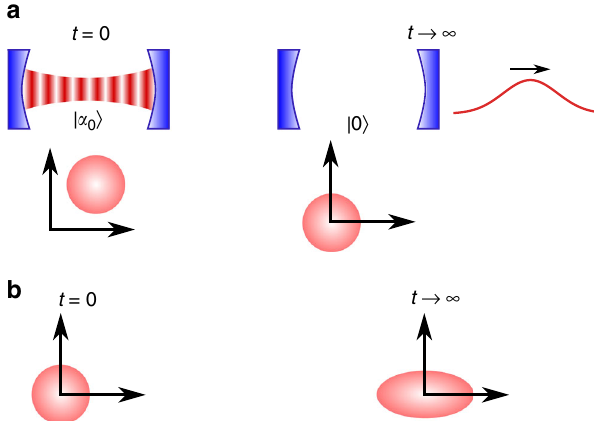
Fig. 2 Interaction of a cavity mode with thermal and non-thermal baths. a A cavity mode initialised in a coherent state decays into the surrounding electromagnetic- fi eld bath to the vacuum state. b A cavity mode prepared in the vacuum state evolves to a squeezed-vacuum state due to its interaction with a squeezed bath. The circles and the ellipse represent the respective phase-space distributions 60 of the fi eld (b)